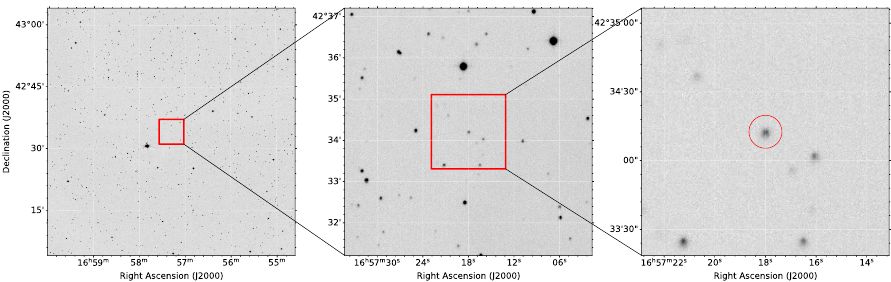
Figure 12. The three panel shows the different zoom scale for the GRB 210420B images. The left panel shows a 1-degree FoV image of the GRB 210420B. The middle panel shows the 0.1-degree FoV of the GRB 210420B. Moreover, the right panel shows the two arcmin FoV of the GRB